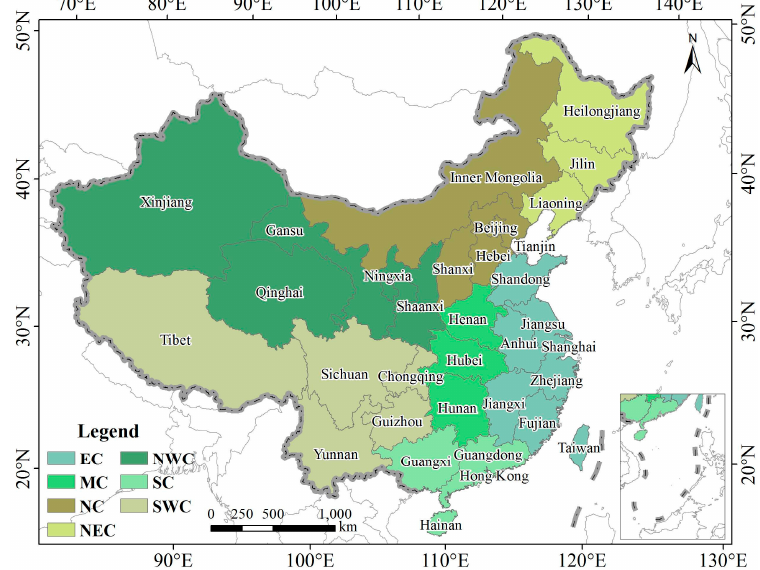
Figure 1. Seven regions of Chinese geography. EC: East China; CC: Central China; NC: North China; NEC: Northeast China; NWC: Northwest China; SC: South China; and SWC: Southwest China.